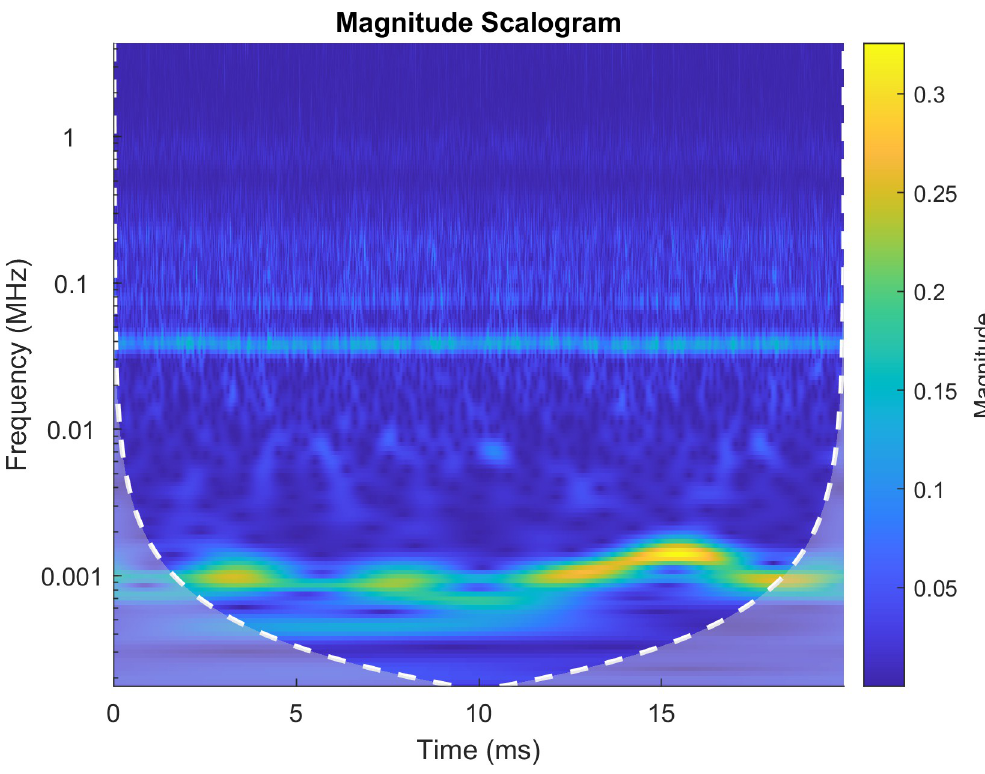
Fig 4. CWT of the input